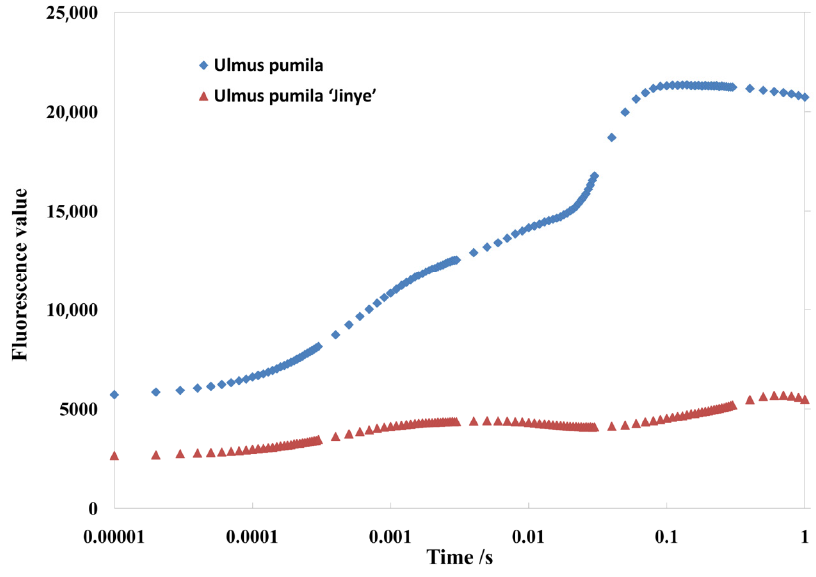
Figure 2. Fluorescence kinetics of O-J-I-P curve of different elms.